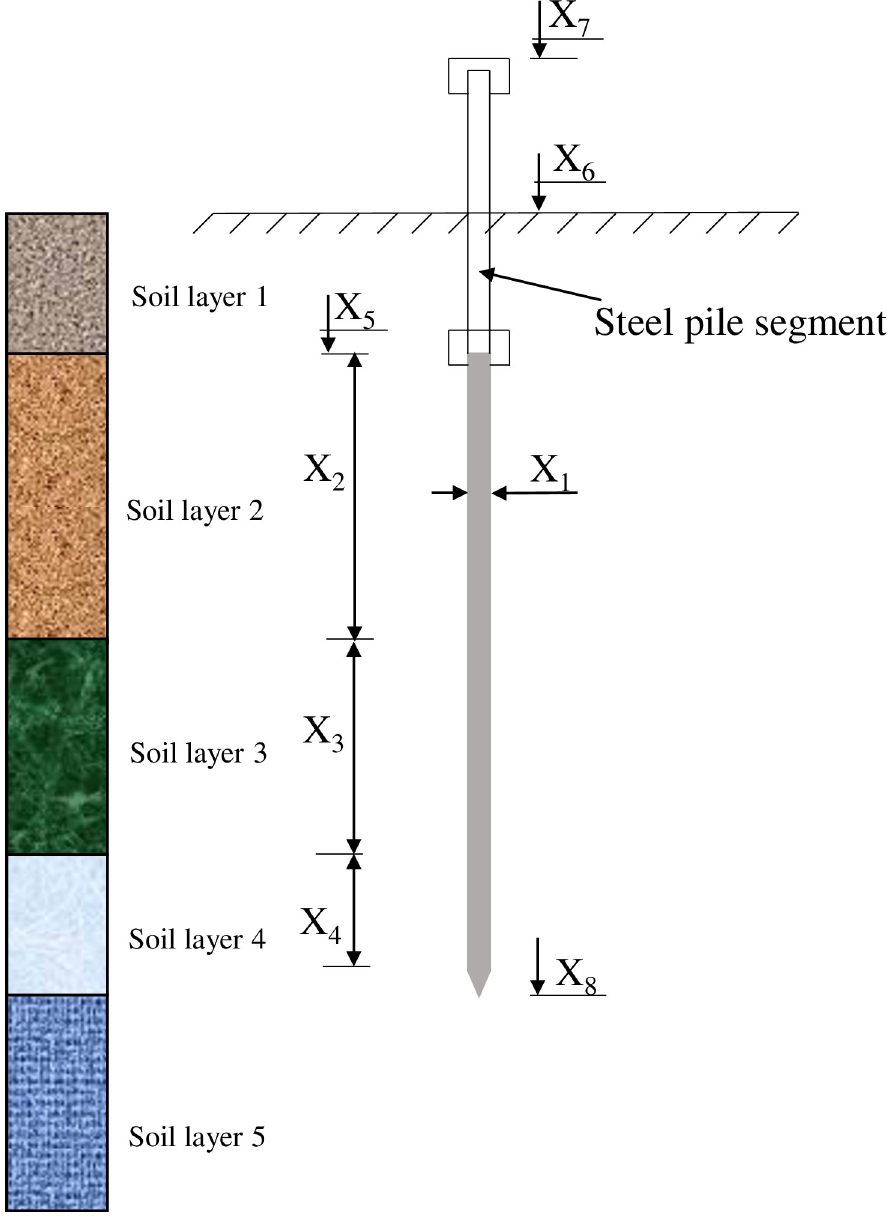
Fig 1. Diagram of pile